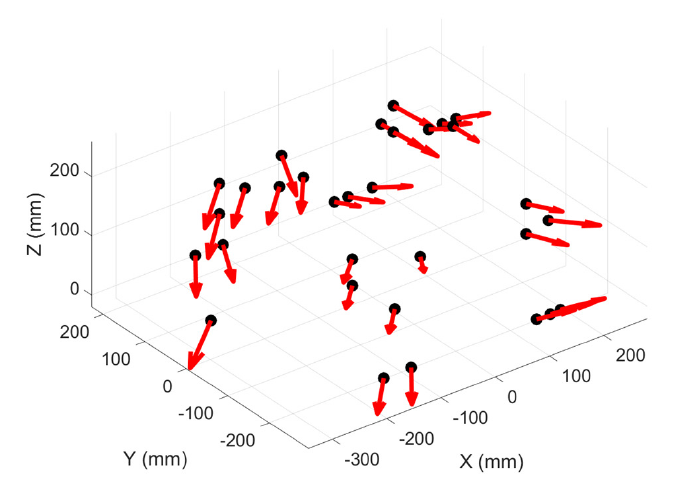
Figure 25. 31 linear axis positions and an example set of TVEs.